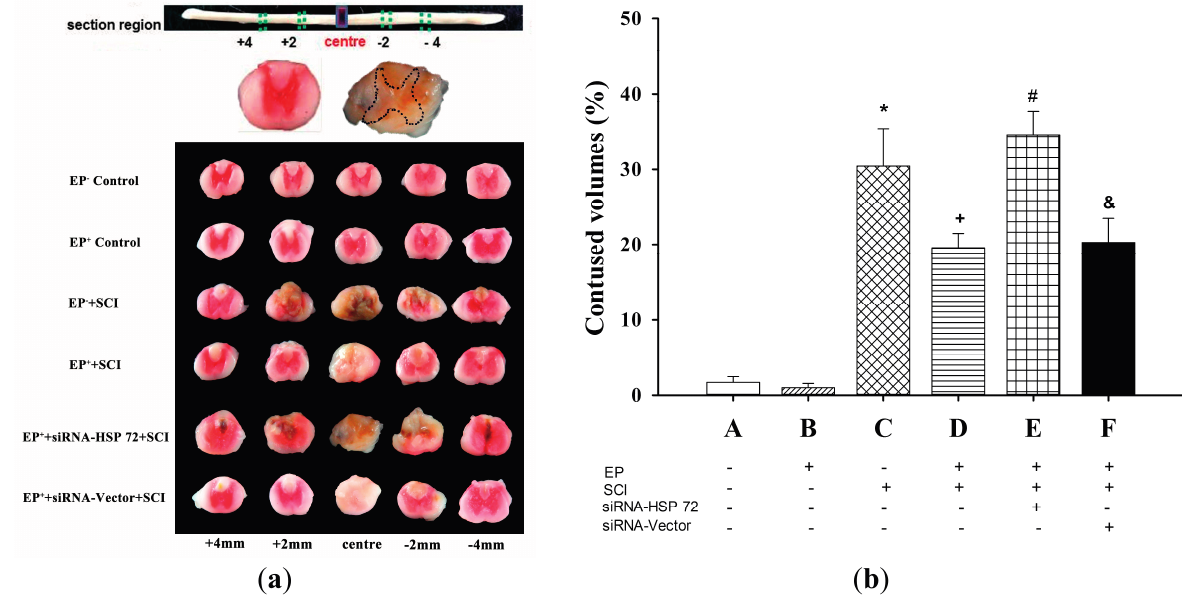
Figure 4. Effect of exercise on spinal cord contused volume following SCI. Contused volume was revealed by negative TTC stains and calculated as 2 mm (thickness of the slice) × (sum of the contused area in all spinal cord slices [mm 2 ] [20]. The contused volumes of five sections from each spinal cord were calculated and summed 7 days after injury or sham operation. Please see the legends of Figure 1 for the abbreviations. The TTC stains presented are representative of results from one EP − control, EP + control, one EP − + SCI, one EP + + SCI, one EP + + siRNA-HSP 72 + SCI + one EP + + siRNA-Vector + SCI ( a ) and Values represent mean ± SD of 8 rats per group ( b ). * p < 0.01 for C vs. A or B; + p < 0.05 for D vs. C; # p < 0.05 E vs. D; & p < 0.05 for F vs. E. Please see the legends of Figure 1 for the explanations of the abbreviations.